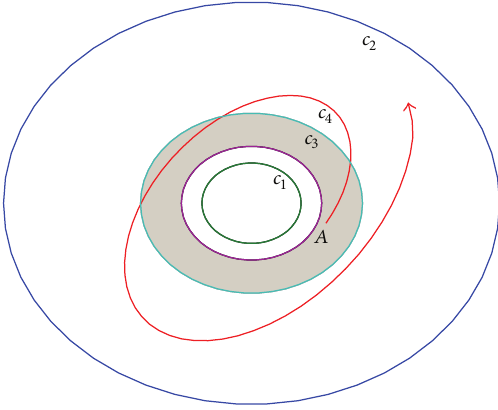
Figure 1: Illustration of finite-time stochastic stability in this paper.